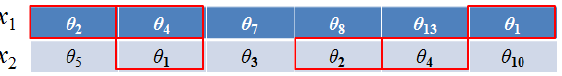
Figure 4. Reverse residual order for similarity metric, where the red rectangles denote the overlapping structures. Given the baseline order { θ 2 , θ 4 , θ 1 } in x 1 , { θ 1 , θ 4 } and { θ 1 , θ 2 } are regarded as the reverse pairs in x 2 . The similarity between x 1 and x 2 then become 0.5 − 0.05 × 2 = 0.4, given h = 6 and β =